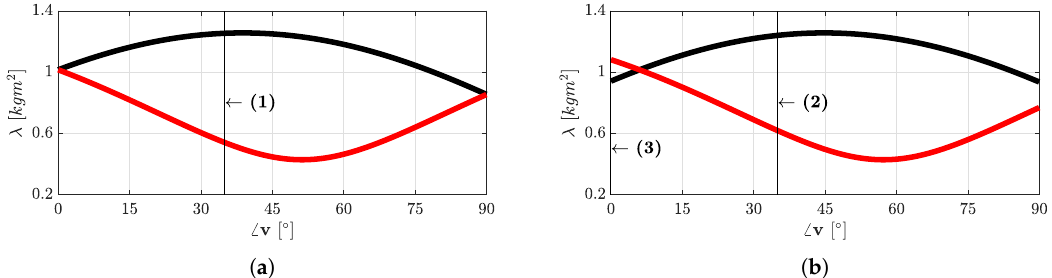
Figure 13. CI ( λ ) for all possible impact directions in the case of ( a ) l n = 0.75 and θ = 0 ◦ and ( b ) l n = 0.75 and θ = 8 ◦ ; bold black and red represent backward and forward flexions, respectively; intersections where the red and black lines meet the lines marked as (1), (2), and (3) denote the sets of